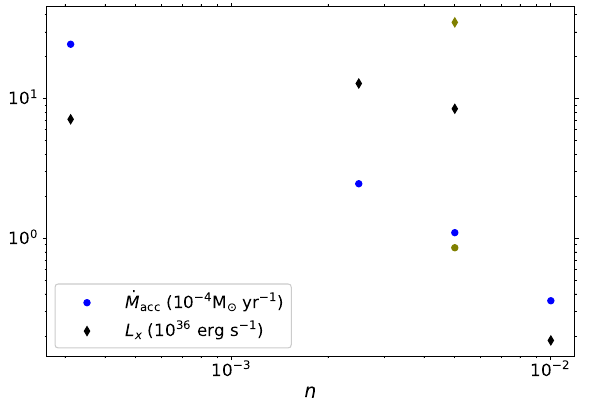
Figure 7. Average mass accretion rate onto the secondary star (blue circles), and average X-ray emission luminosity (black squares). The average X-ray emission excludes the initial X-ray peak which is the result of interaction of the enhanced wind with the previous CWS from the fiducial run (Run 1). The orange symbols are for Run 4 that includes orbital